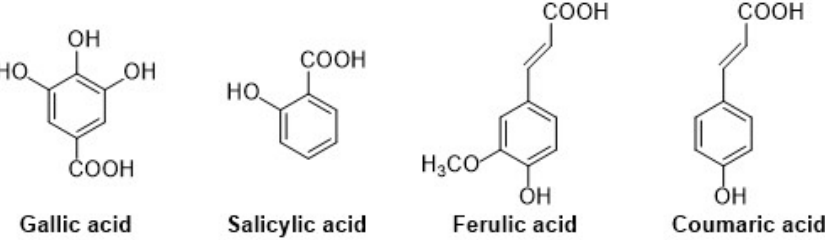
Figure 4. Chemical structure of gallic (hydroxy group at 3rd, 4th, and 5th position), salicylic (hydroxy group at ortho position), ferulic (hydroxy group at 3rd and 4th position on phenyl ring), and coumaric acids (hydroxy group at 4th position on phenyl ring).